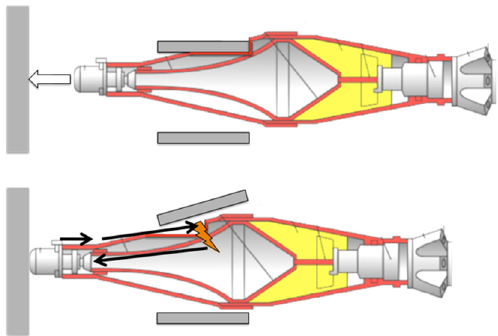
Figure 4. Working principle of the cage armour showing the short-circuiting of the inner and outer cone before the impact of the piezoelectric element on the hull of the target. Due to the short-circuit the main current will pass through the short-circuit instead of through the detonator.